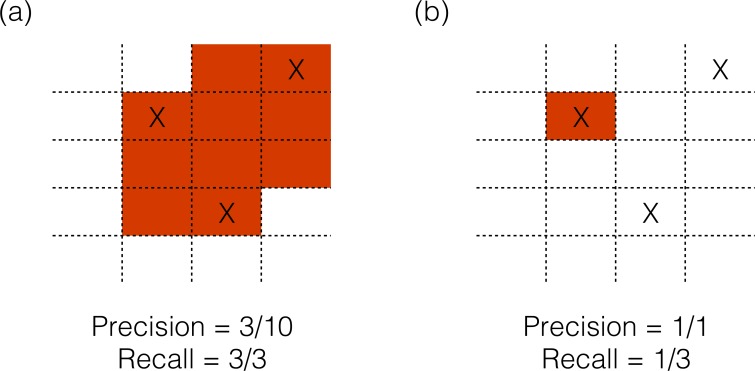
Schematic example of Precision and Recall calculation.Real source locations are represented by “X” marks. Red shading represents a hypothetical source reconstruction. (a) If an algorithm designates a large area as active, it is likely to find all sources, but the Precision of the reconstruction will be low. (b) If an algorithm is more conservative, Precision is high, but Recall is low as not all sources are found.